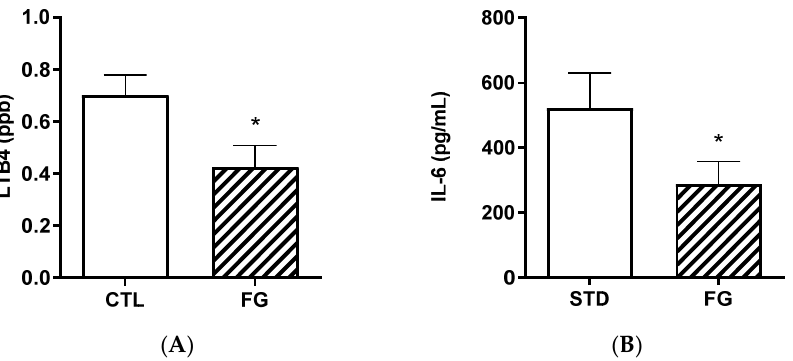
Figure 5. Biomarkers of inflammation, LTB4 ( A ) and IL ‐ 6 ( B ) in plasma from rats ( n = 8–9) supple ‐ mented or not with D ‐ fagomine for 6 months. Comparisons were conducted using Student’s t ‐ test. * p < 0.05.